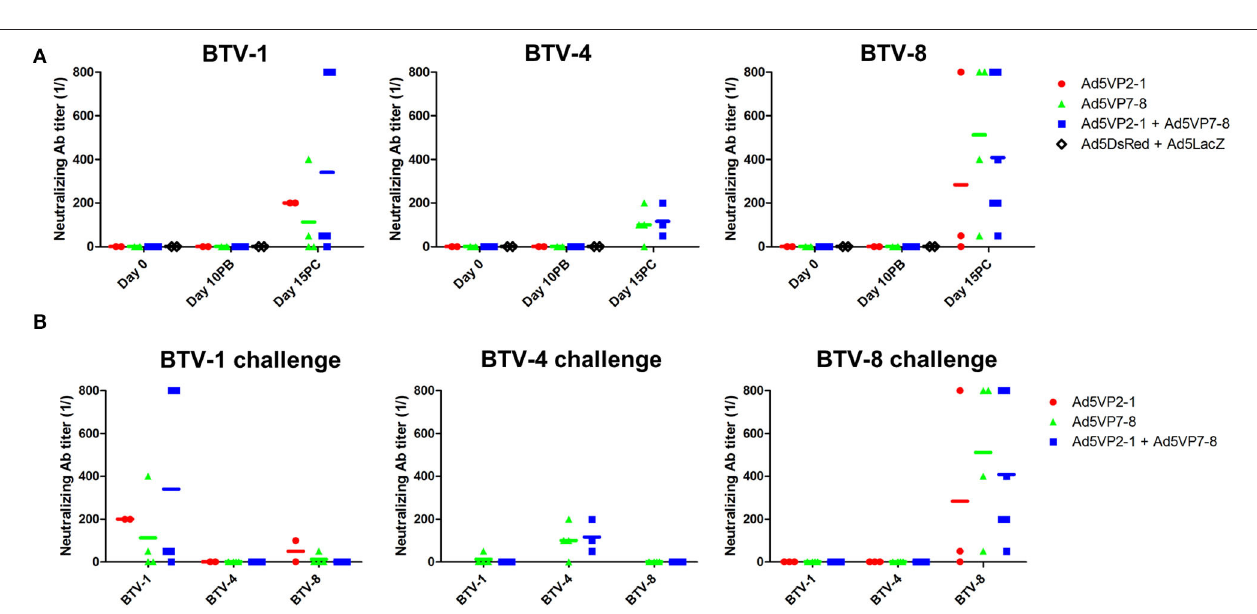
FIGURE 4 | The Ad5VP2-1 and Ad5VP7-8 immunization does not produce significant levels of BTV-neutralizing antibodies. (A) BTV-1, − 4, or − 8 (100 PFU) preincubated with diluted sera were used to infect Vero cells to assess the presence of BTV neutralizing antibodies. Sera obtained prior to immunization (day 0) at 10 days after booster vaccination (day 10PB) and at 15 days after BTV challenge (day 15PC) in surviving mice ( n = 2–6/group) were used in these experiments. Data are presented as the reciprocal dilution at which < 50% complete cytopathic effect (CPE) was observed. (B) The presence of neutralizing antibodies cross-reactive to other BTV serotypes in the sera of mice that survived the challenged was assessed using day 15 post-challenge sera. The serotype specified above the plot indicates the challenge received by the mice, while the x-axis shows the BTV serotype used for